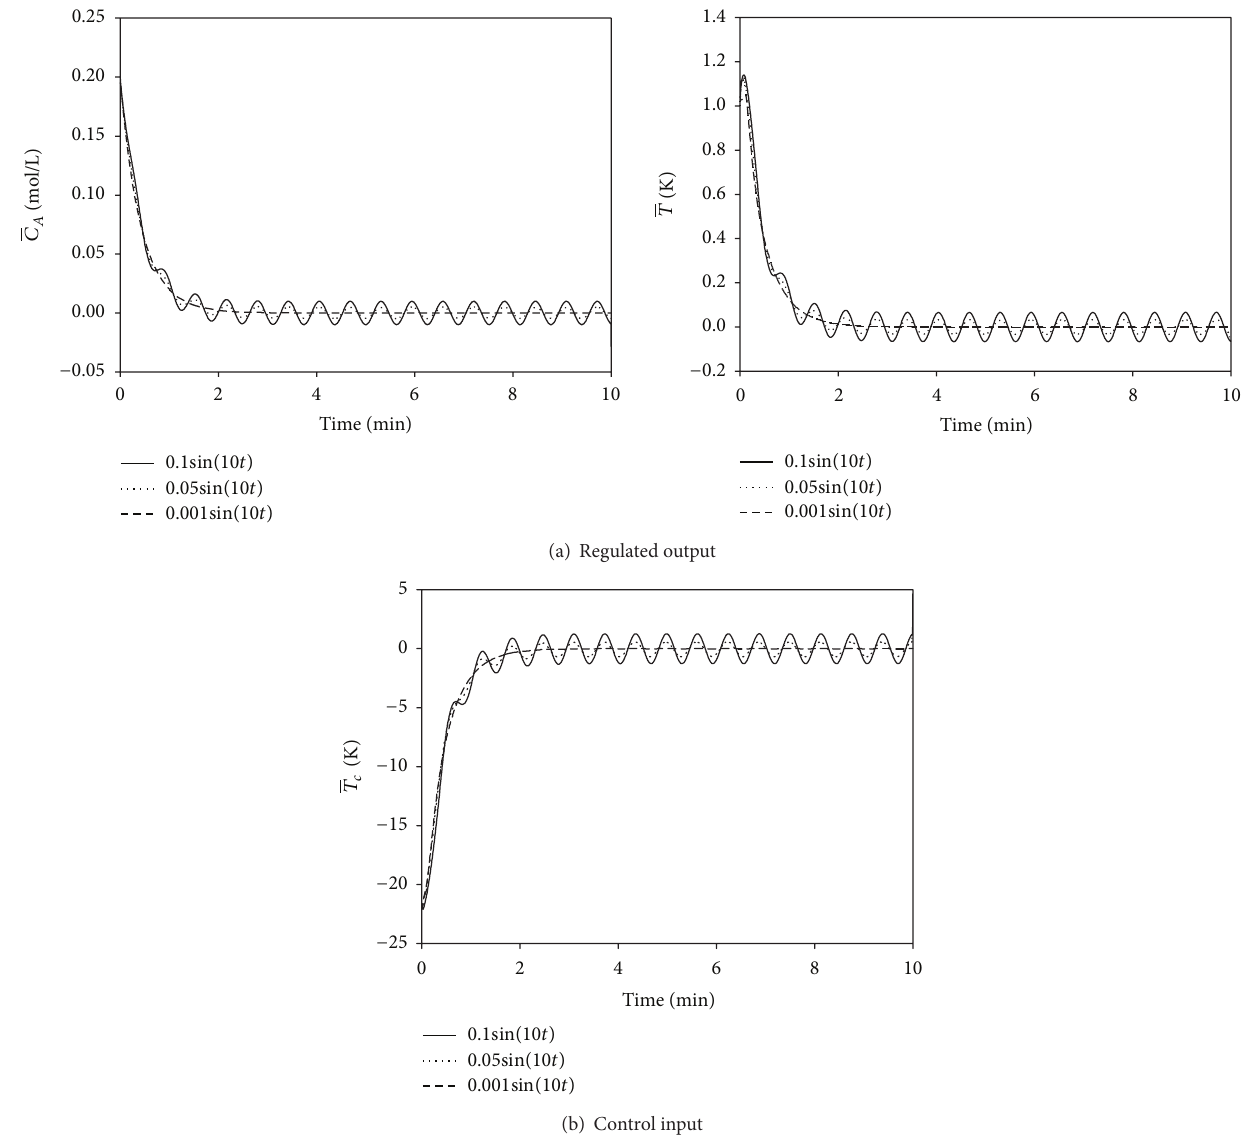
Figure 2: The closed-loop responses in Example 1 (a) regulated output and (b) control